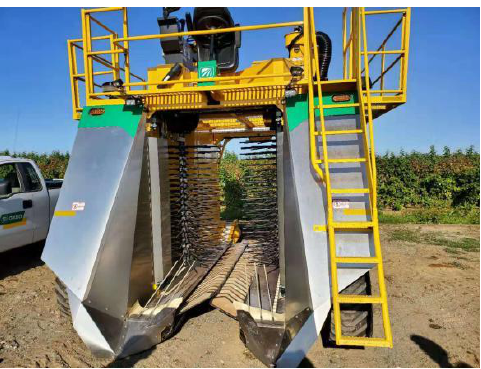
Figure 1. Oxbo modified over-the-row (OTR) 7440 harvester (Oxbo International Corp., Lynden, WA, USA) used in the 2019 and 2020 harvest interval experiments.